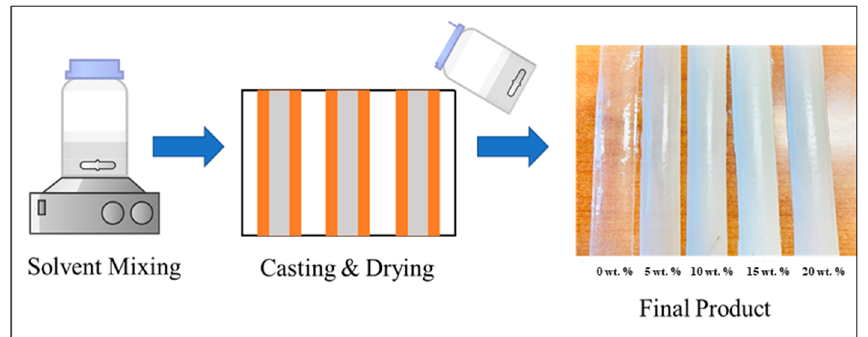
Figure 1. Experimental procedure of CA/AlN composites.